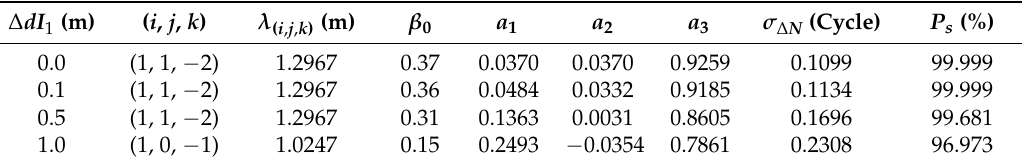
Table 3. Suboptimal BDS triple-frequency code-phase combinations and the corresponding AR success rate for different code noises and ionosphere